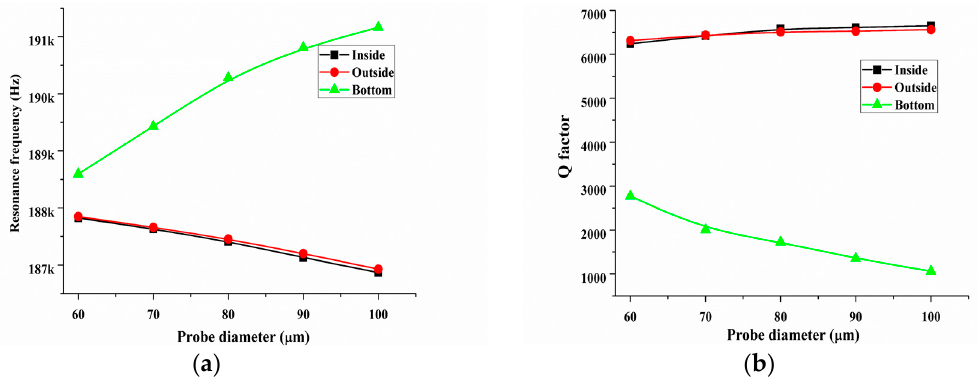
Figure 11. ( a ) Resonance frequency and ( b ) Q -factor with the increase of the tungsten probe diameter under the probe connection configurations of inside, outside and bottom.